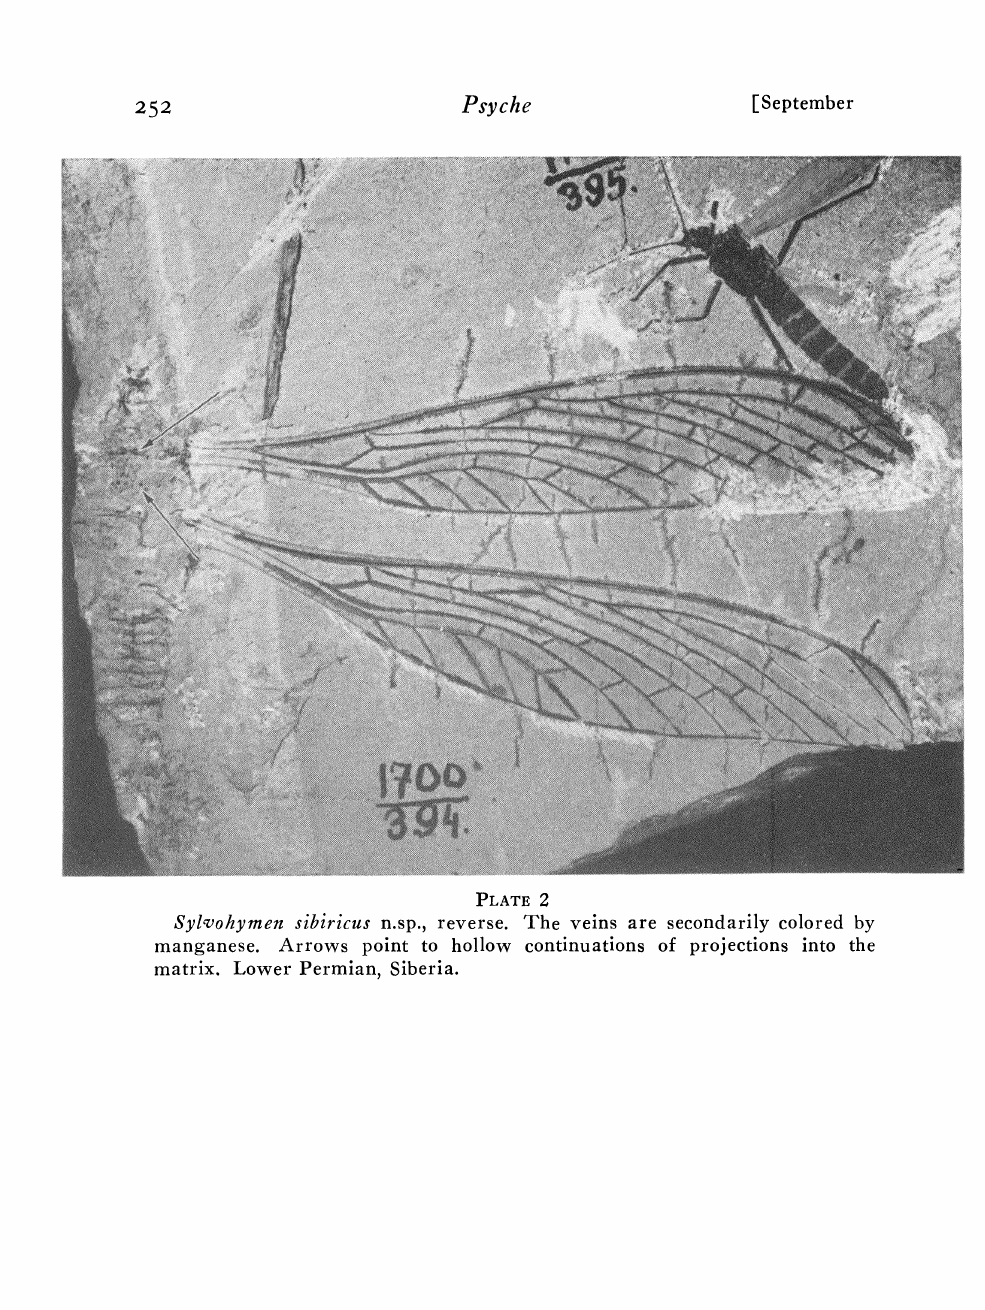
PLATE 2 Sylvohymen sibiricus n.sp., reverse. The veins are secondarily colored by manganese. Arrows point to hollow continuations of projections into the matrix. Lower Permian,